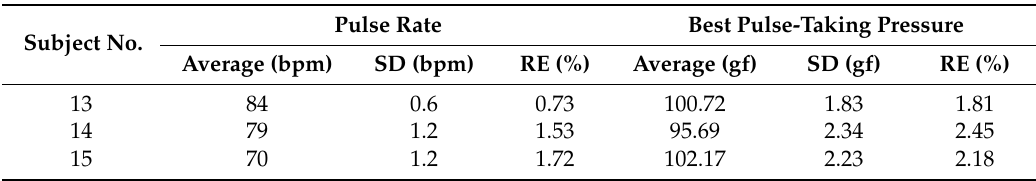
Table 2. Experiment results.